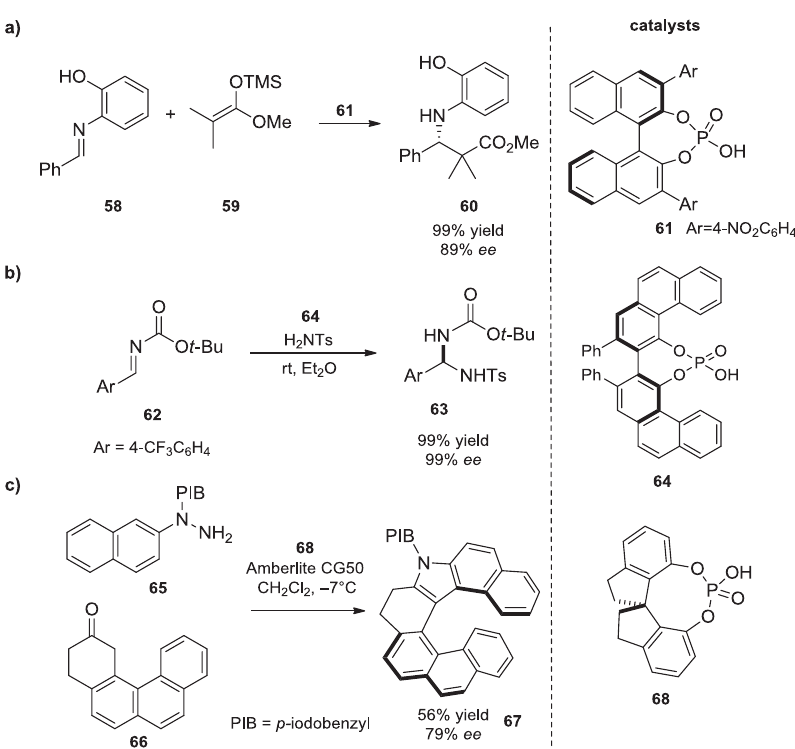
Figure 16. (a) Enantioselective Mannich-Type reaction, from Ref. [75, 76]; (b) BA-catalyzed imine amidation, from Ref. [85]; (c) Fischer indolization, from Ref. [84].